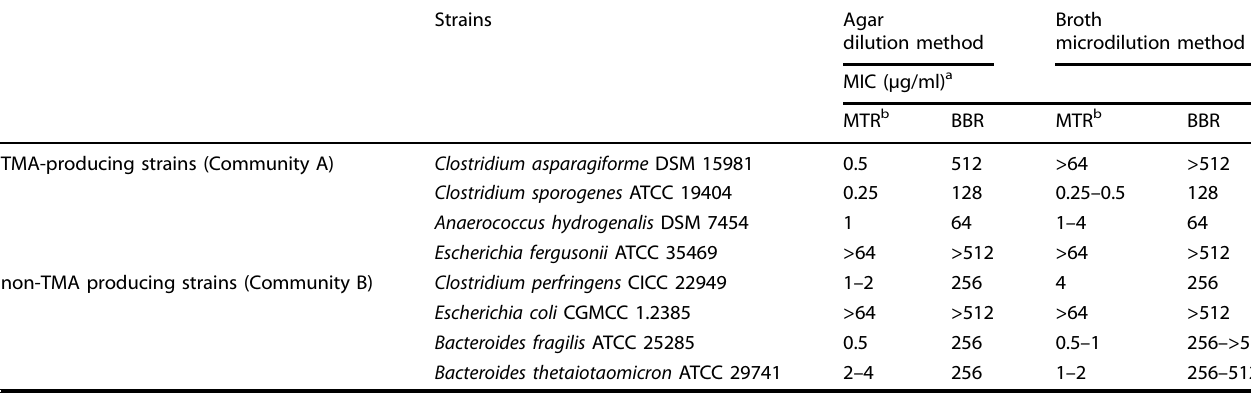
Table 1. Minimum inhibitory concentration (MIC) of BBR on human commensal bacteria under anaerobic condition.